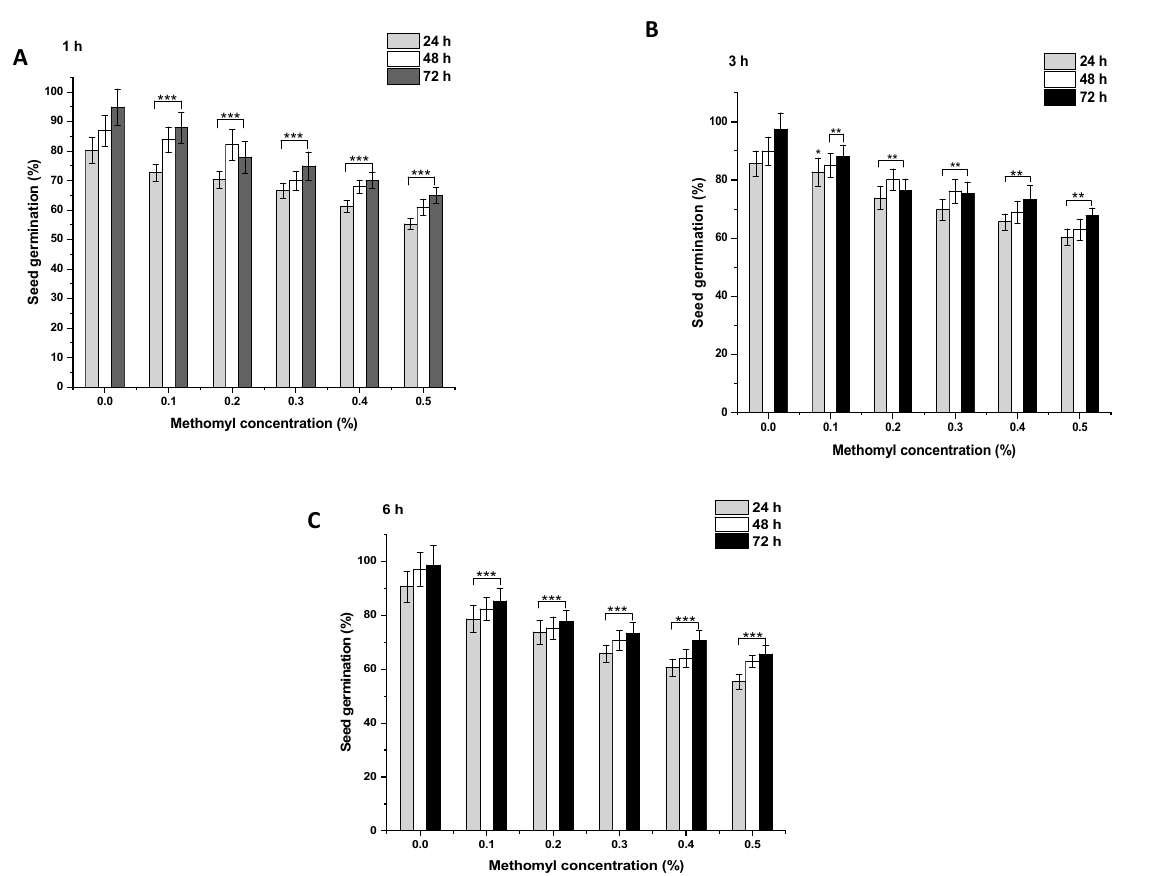
Figure 2. Seed germination (SG) in P. sativum seeds exposed to methomyl (ME) for ( A ) 1 h, ( B ) 3 h and ( C ) 6 h at 24, 48, and 72 h after exposure. Data represent mean and SE. The experiment was repeated thrice. * p < 0.05; ** p < 0.01 and *** p < 0.001 compared to control at respective time interval.